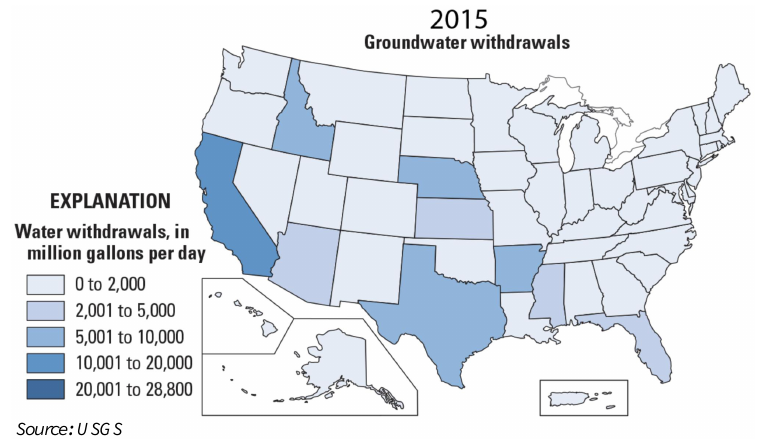
Figure 5. Groundwater withdrawals in United